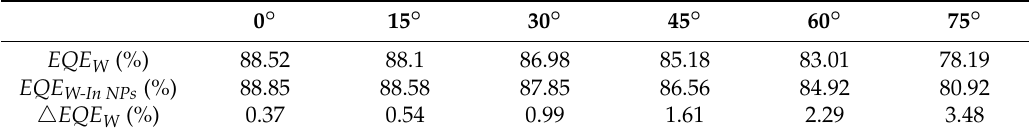
Figure 10. Average weighted EQE ( EQE W ) of cells at each AOI, as calculated using Equation (9). Table 2. Average weighted EQE ( EQE W ) and improvement in EQE W ( ∆ EQE W ) at each AOI.